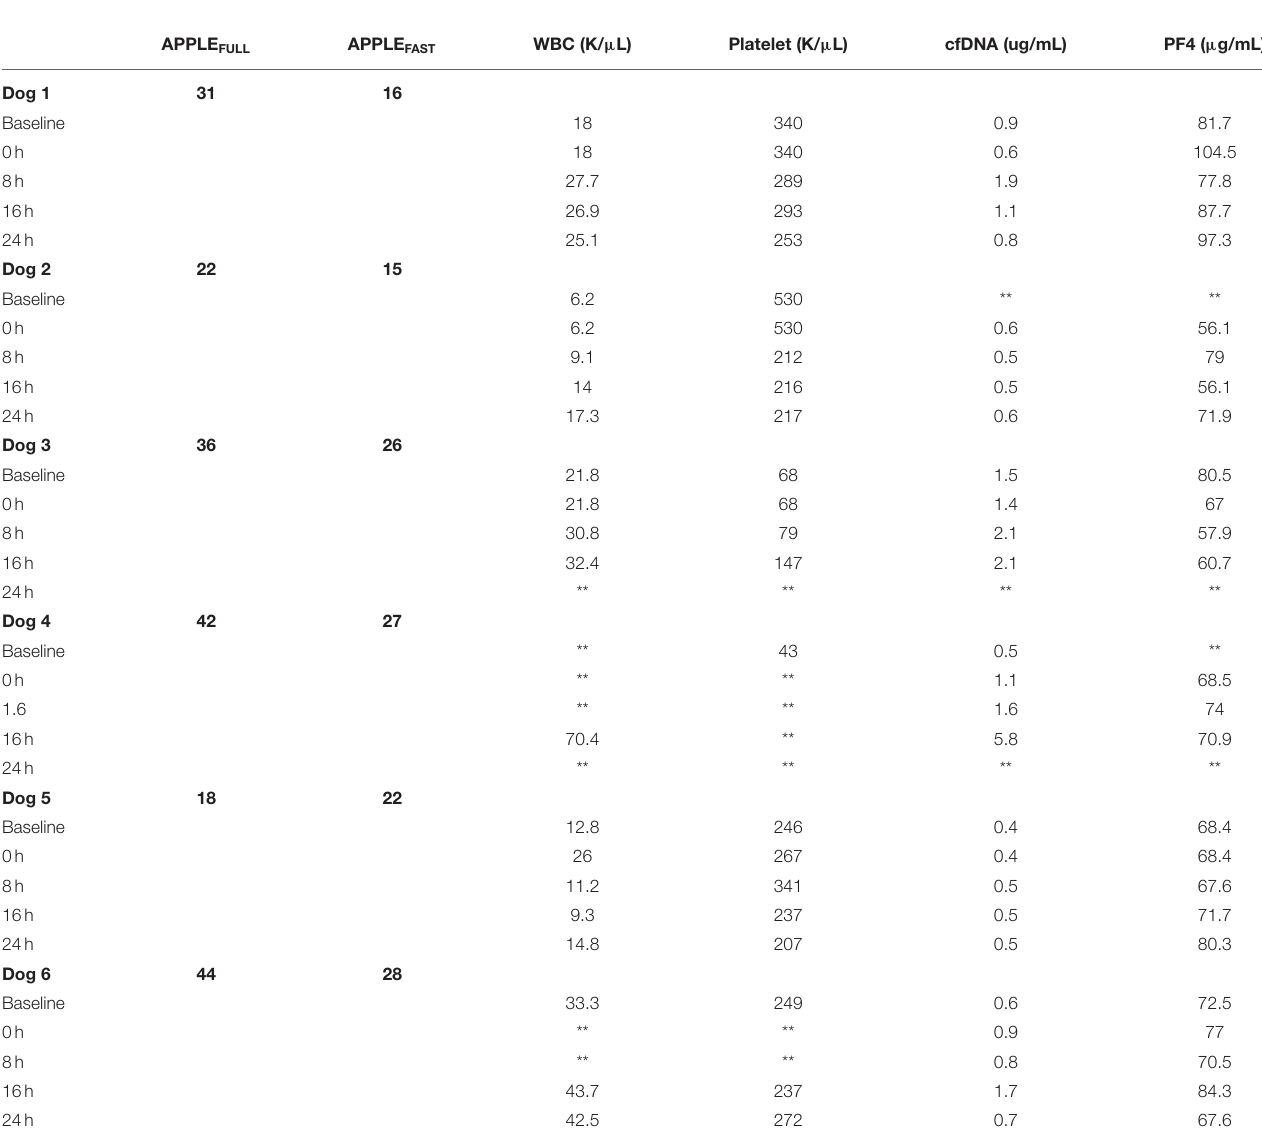
TABLE 3 | This table contains APPLE scores performed at admission and WBC count, platelet count, cfDNA concentration and PF4 concentration collected at each study time